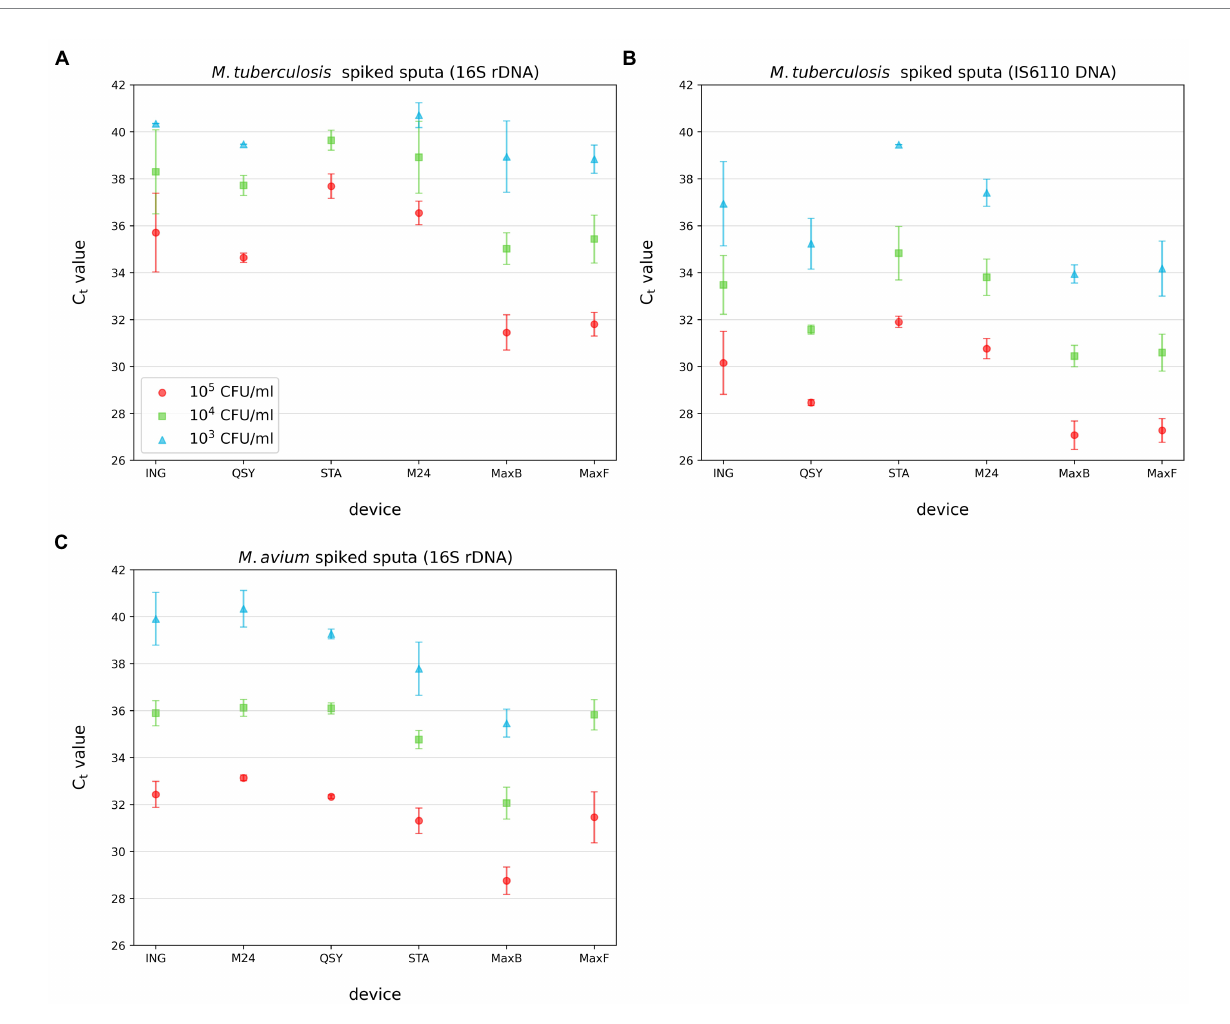
FIGURE 1 DNA yields for extraction with six device-kit combinations. Each plot (A–C) shows real-time PCR C t values following extraction with each device-kit combination. Tests were carried out on sputa spiked with either M. tuberculosis (A,B) or M. avi um (C) at 3 concentrations ranging from 10 3 to 10 5 CFU/ mL (colony-forming units/mL). The error bars give the standard deviation of the mean of experimental triplicates. Device-kit combinations are denoted: ING (ELITe InGenius [SP200 Kit]), QSY (Qiagen QIAsymphony [DSP Virus Pathogen Midi Kit]), STA (Hamilton Genomic STARlet [STARMag Universal Cartridge kit]), M24 (Roche MagNA Pure 24 [Total NA Isolation kit]), MaxB (Promega Maxwell 16 [RSC Blood DNA Kit]), and MaxF (Promega Maxwell 16 [RSC Pure Food Pathogen Kit]). Workflow: Sample => Decontamination (NALC-NaOH) => DNA isolation =>